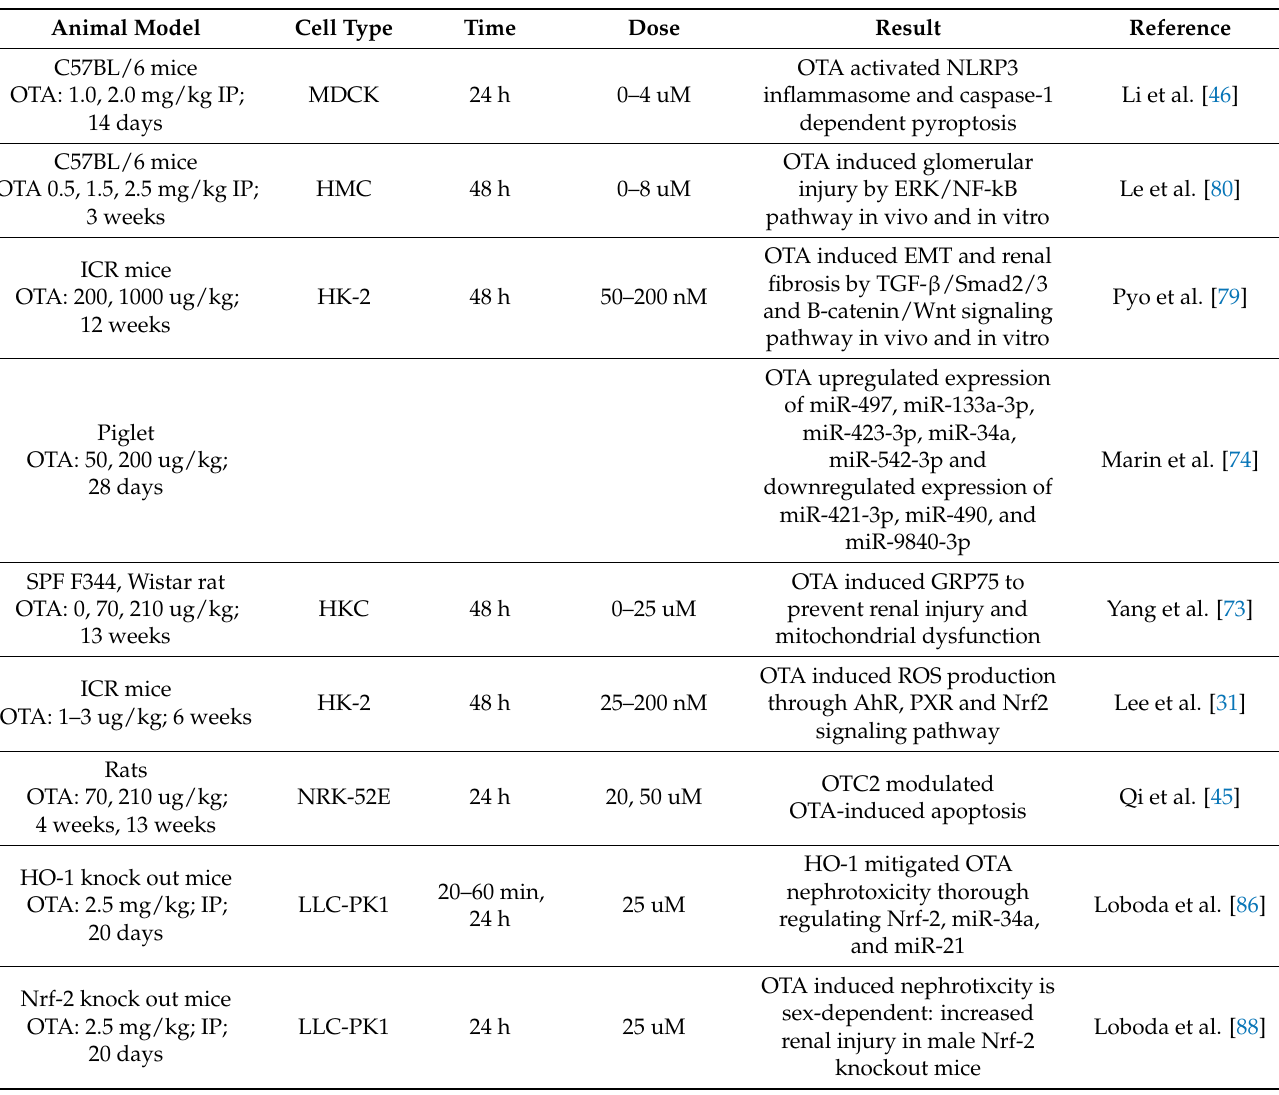
Table 2. In vivo OTA-induced nephrotoxicity